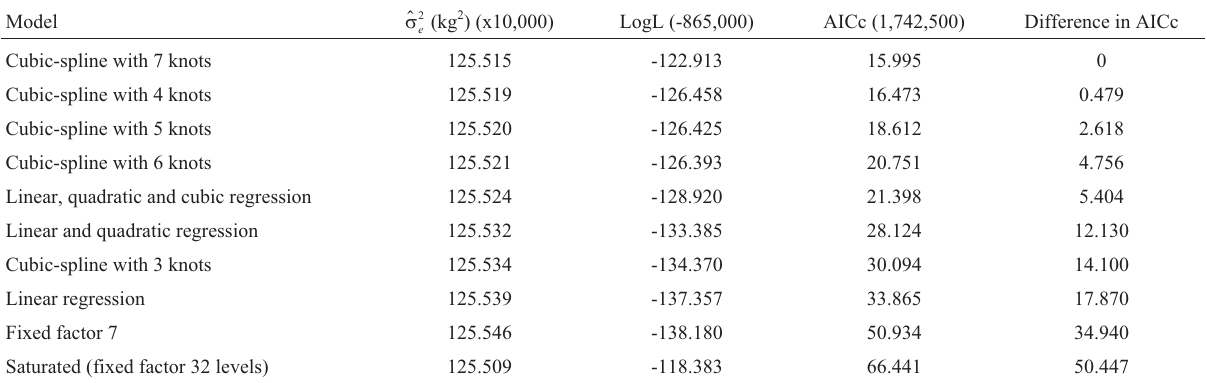
Table 3 - Estimates of residual variance, logarithm of the likelihood and AICc for each model, with differences in AICc from the cubic-spline model with seven knots.